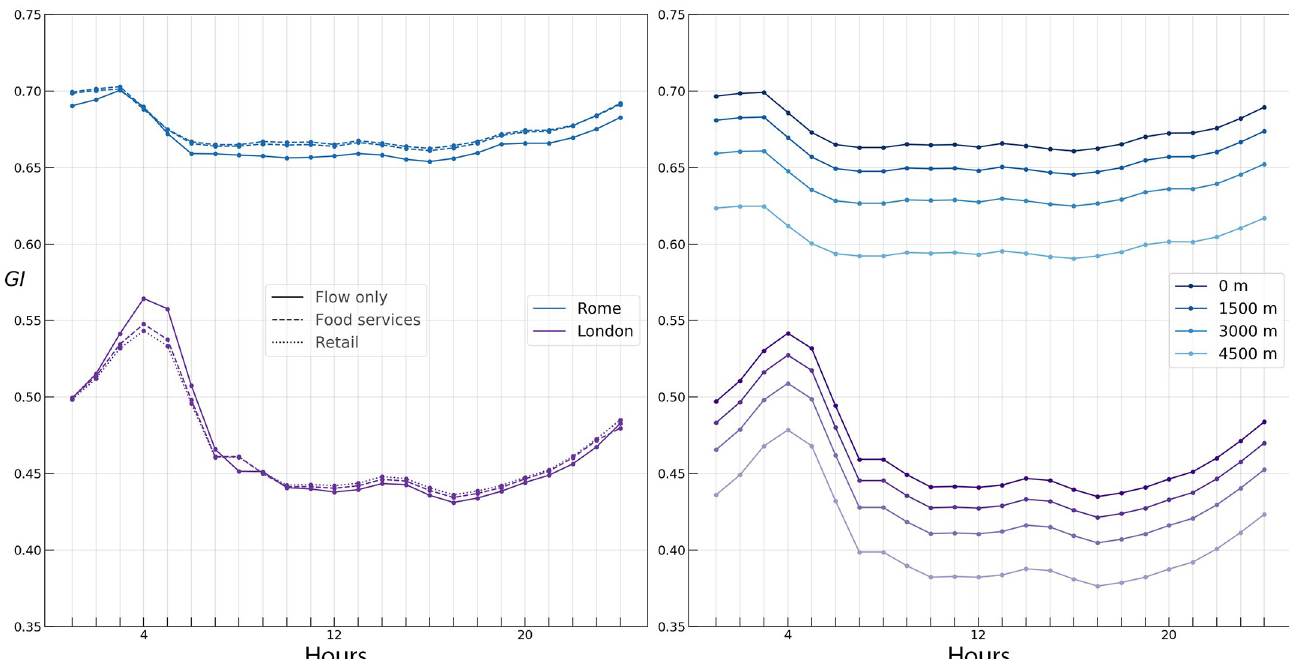
Fig 6. Gini (left) and Spatial Gini (right) coefficients during the day for flow only, food service, and retail activity in Rome and London.